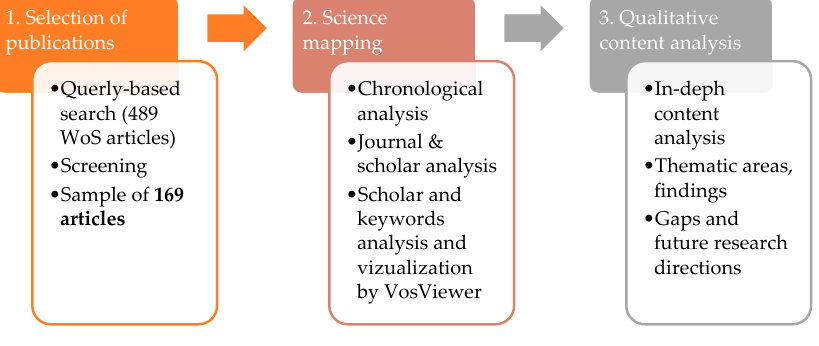
Figure 1. Research Figure 1. Research fl owchart.